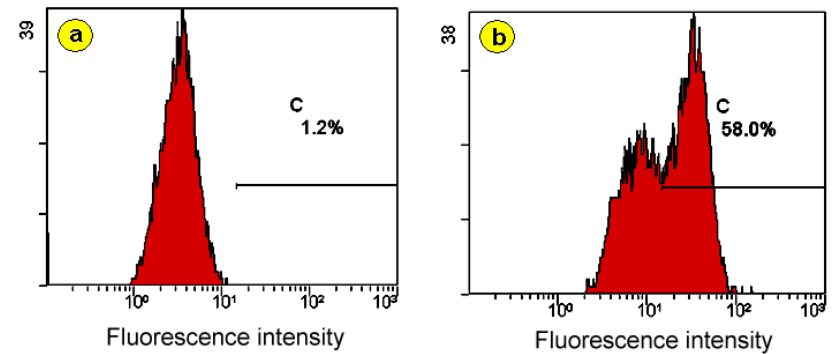
Figure 4. The flow cytometric results of the functionalized GO adsorbed experimental NB4 group cells with the PML/RAR α fusion gene ( a ) without and ( b ) with intervention of the FITC-labeled single-stranded DNA